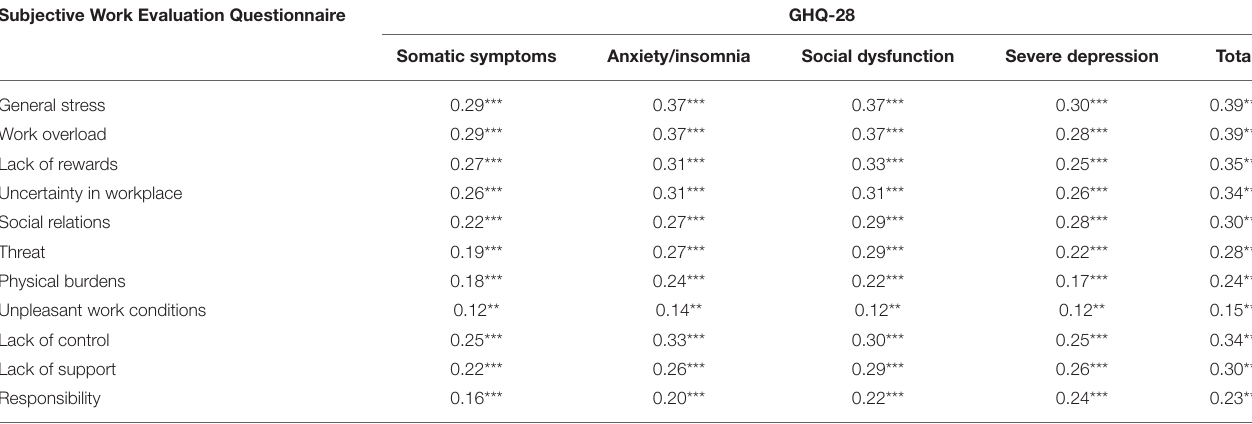
TABLE 5 | Spearman correlation coefficients between the assessment of negative work characteristics and mental health measures. Subjective Work Evaluation Questionnaire